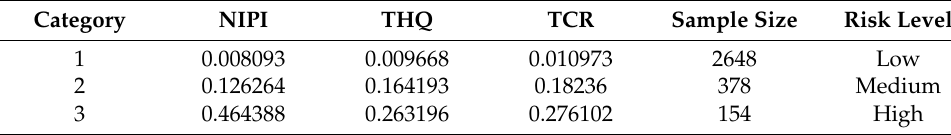
Table 2. Clustering center and